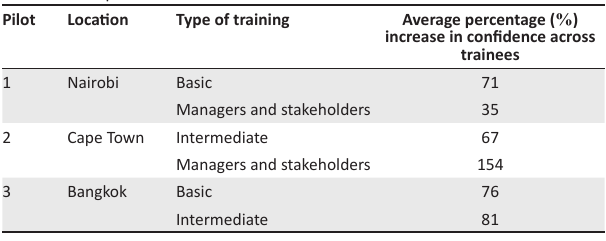
FIGURE 2: Trainees’ average satisfaction ratings across Pilot 1 (Nairobi), Pilot 2 (Cape Town) and Pilot 3 TABLE 3: Self-perceived confidence to deliver the WHO WSTPt.